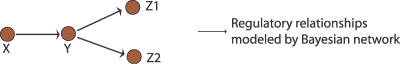
Probabilistic Graphical ModelsDirected acyclic graphical models are called Bayesian networks. In the shown Bayesian network, values of variable Y depend directly on values of X, and values of variable Z1 and Z2 depend directly on values of Y.